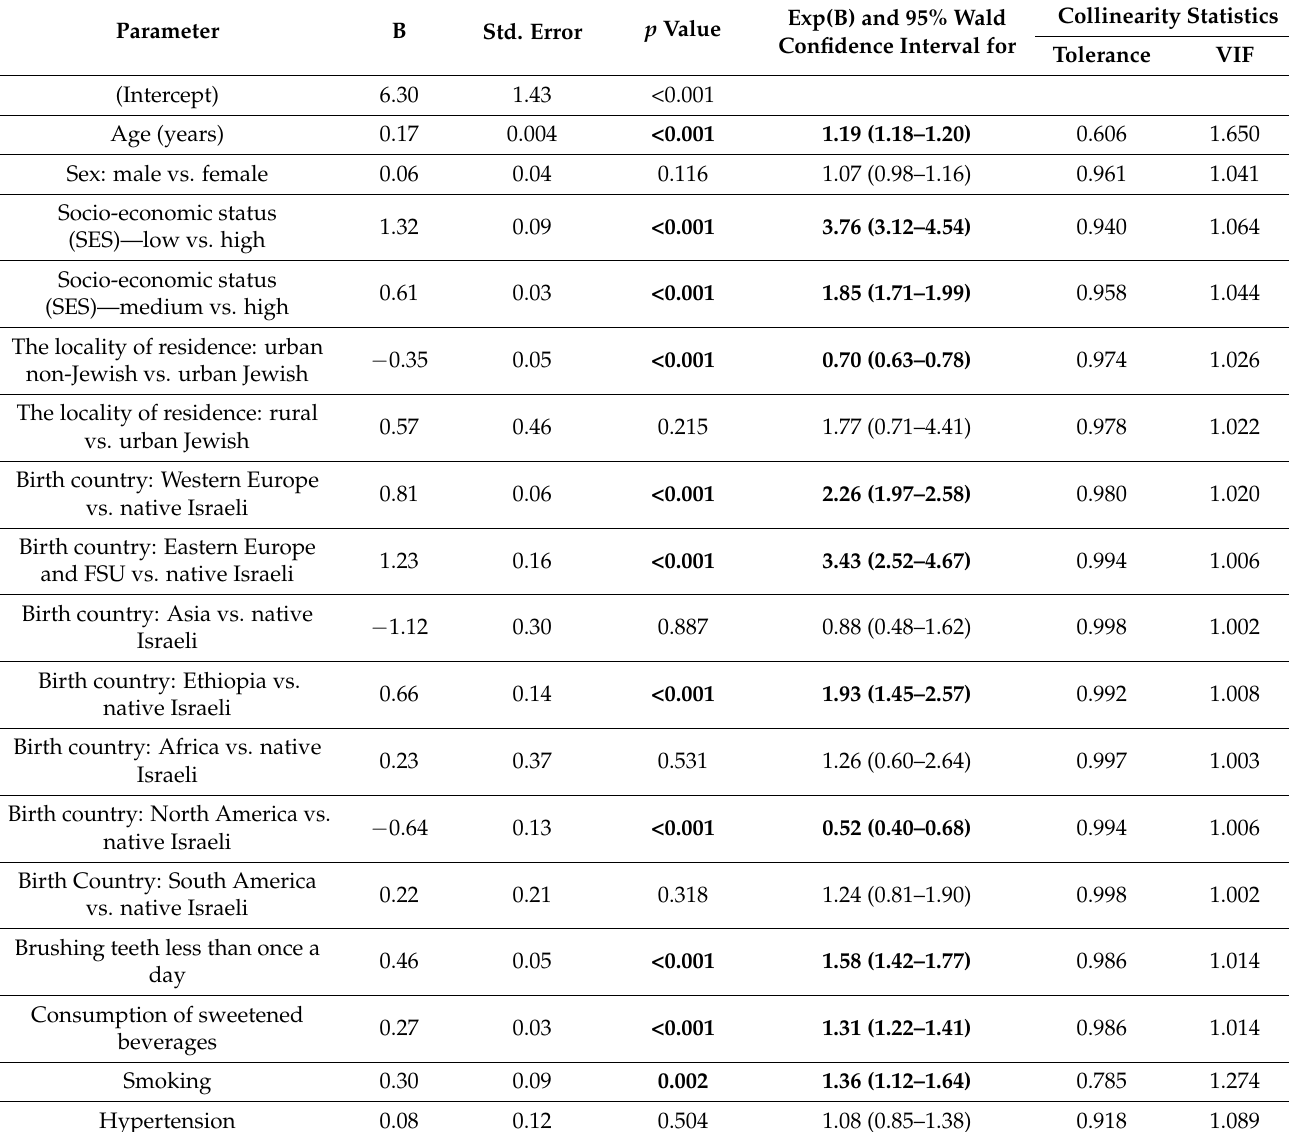
Table 6. Multivariate linear regression analysis for SDU-P (planned procedures) as the dependent variable with statistically significant independent parameters including collinearity statistics (statistically significant parameters are in bold